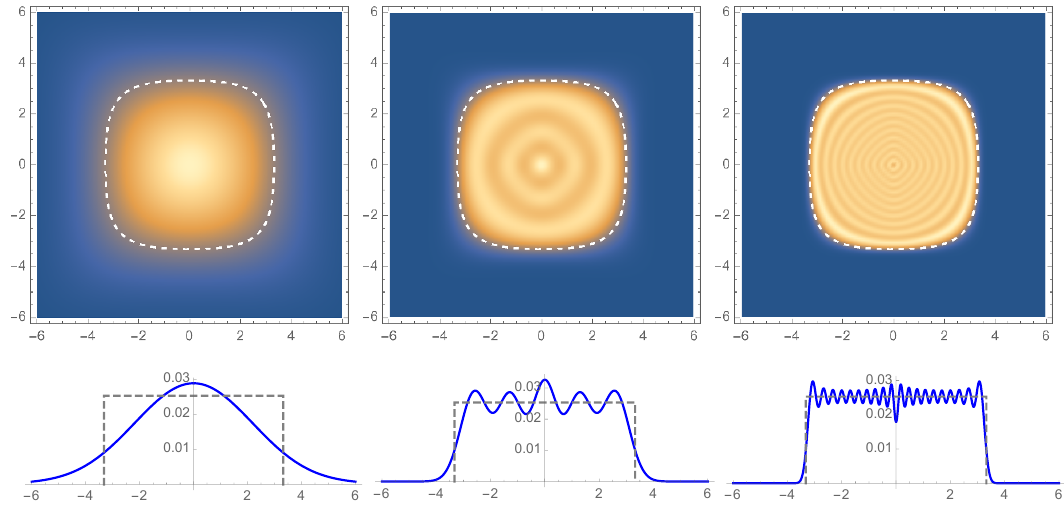
Figure 3 . Top: density plot of the quantum distribution ( x; p ) in phase space for local F 0 , Q N compared to the classical mirror curve (3.59), which is shown as a white dashed line. In all cases, we have N= ~ = (2 (cid:25) ) (cid:0) 1 . On the left we show the distribution for N = 1 (where the distribution is given by (3.62)), in the middle we show N = 5, and on the right we show N = 20. In the bottom, we show the restrictions of the same distributions to the slice p = 0, as well the classical limit (3.61) in dashed lines.